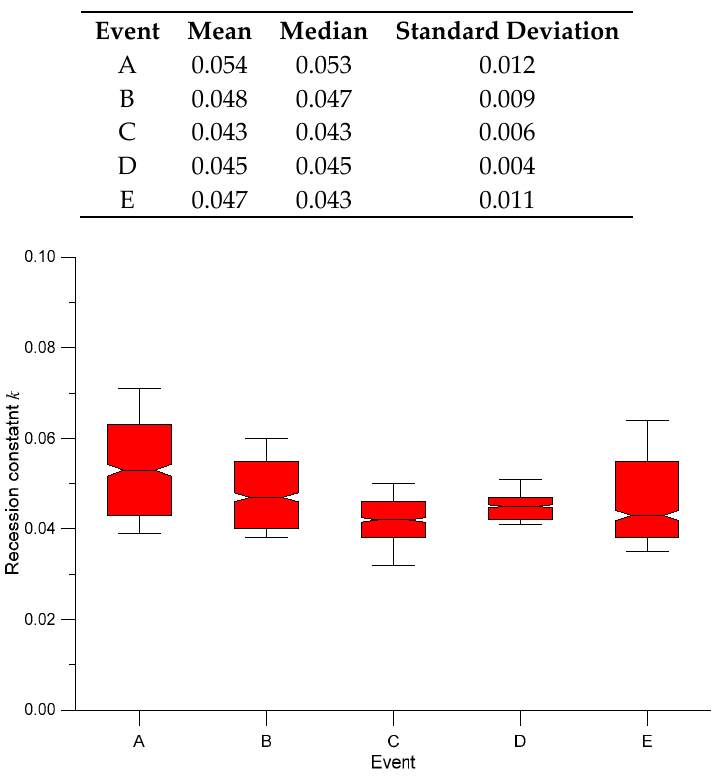
Table 2. Statistics of k value datasets.